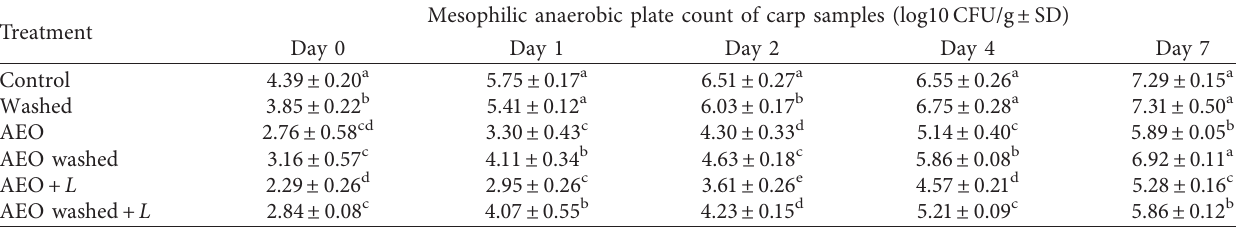
Table 2: Effects of washing, acidic electrolyzed oxidizing water, and lysozyme treatments on the mesophilic anaerobic plate count of carp samples.